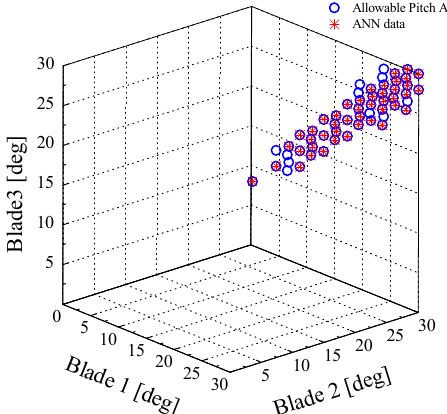
Figure 10. APA and ANN data for M a of 20 m/s.